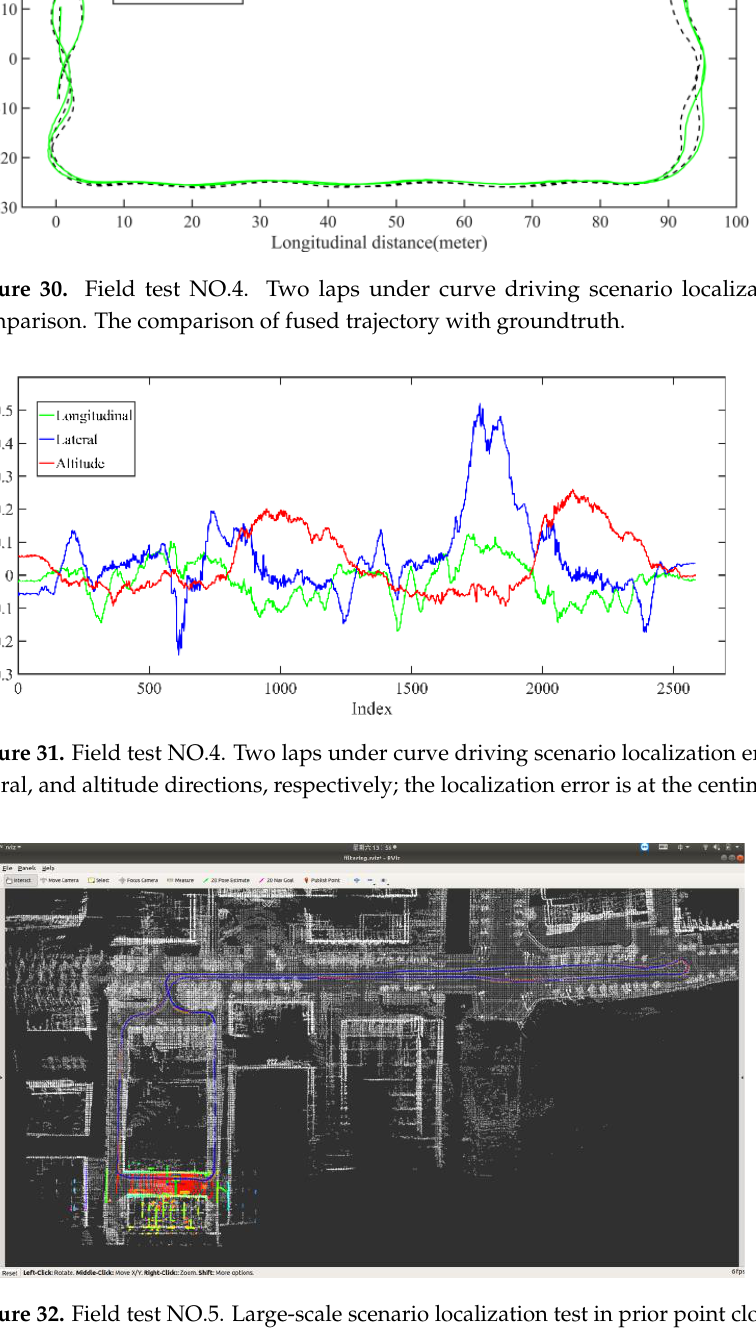
Figure 32. Field test NO.5. Large-scale scenario localization test in prior point cloud map. The white points in the figure are the point cloud map built by the offline mapping process, the red line is the trajectory of LiDAR matching results, the orange line is groundtruth, and the blue line is the fused trajectory.